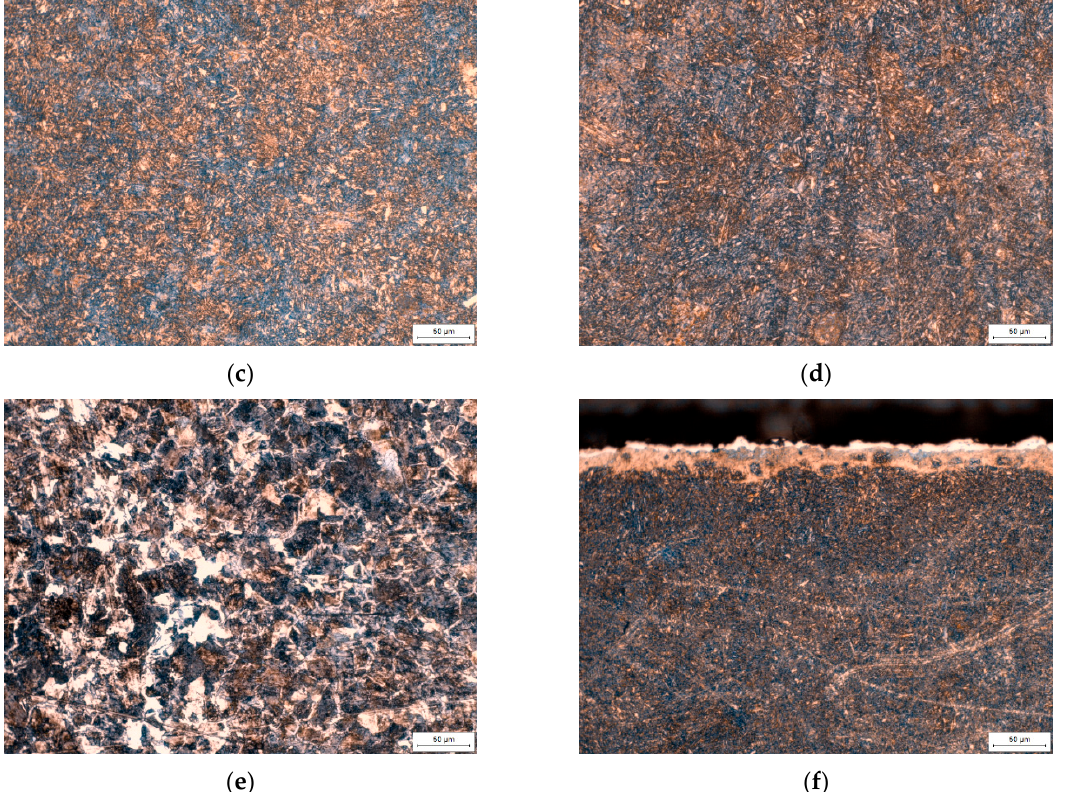
Figure 8. View of metallographic structures; ( a ) steel 45, ( b ) normalizing, ( c ) flame hardening + high tempering, ( d ) flame hardening + low tempering, ( e ) nitriding and ( f ) diffusion chrome hardening.